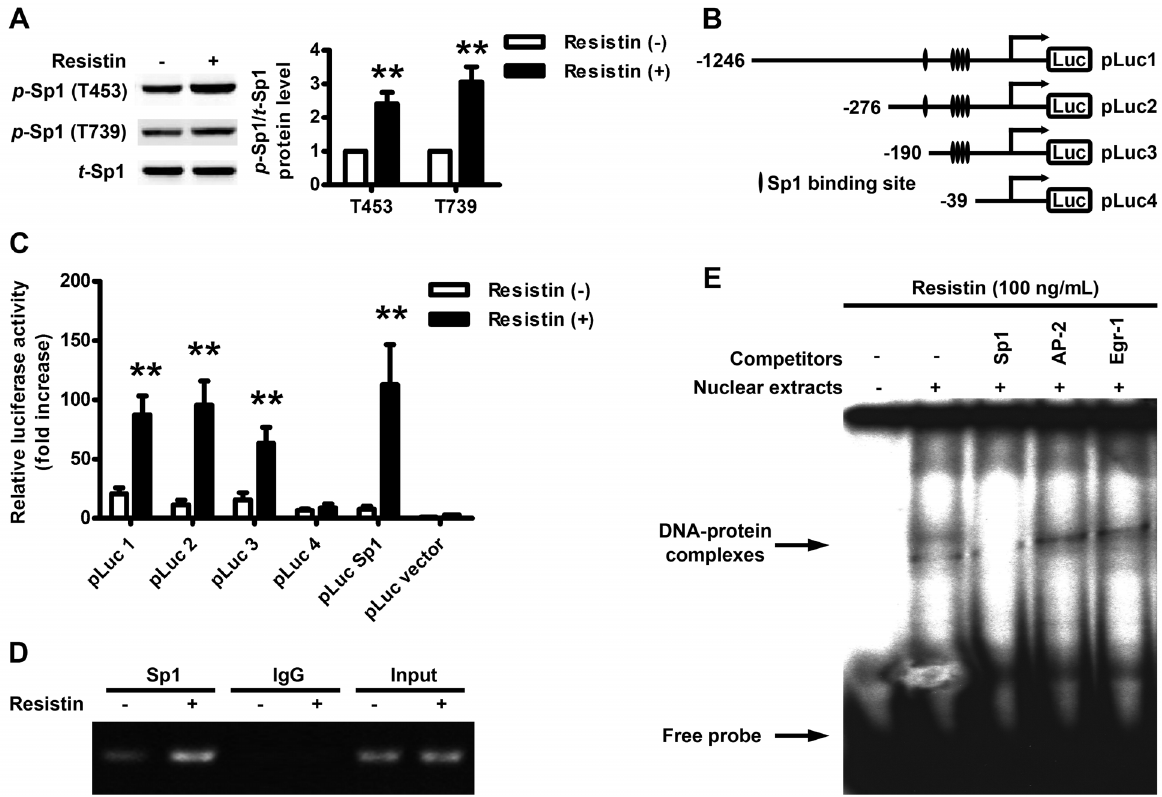
Figure 3. Sp1 acted on the motif of VEGF promoter. ( A ) Effects of resistin on Sp1 activation in HO-8910 cells. Cells were incubated with 100 ng/mL resistin for 2 h and whole-cell lysates underwent Western blotting to detect the phosphorylation of Sp1 at either Thr-453 or Thr-739; ( B ) Scheme of the series of plasmid constructs containing dissected fragments of VEGF promoter; ( C ) Relative luciferase activity in transient transfection assays using the series of plasmid constructs (schematically shown in B ) and pSp1-luciferase reporter. Relative luciferase activity was normalized with respect to the activity of PGL3-basic in untreated cells. Data are mean ± SEM from four independent triplicated experiments; ( D ) Chromatin immunoprecipitation of VEGF promoter complexes. HO-8910 cells underwent immunoprecipitation with anti-Sp1 antibody or control IgG. Immunoprecipitated chromatin fragments were amplified by PCR with specific primers targeting the predicted Sp1 binding motifs within the VEGF promoter; ( E ) Effects of various competitors in EMSA of resistin-stimulated HO-8910 cells. Competitors, including Sp1, AP-2 and Egr-1 consensus sequences, were added to the reaction mixture at a 100-fold molar excess to labeled probe, the VEGF promoter fragment containing predicted Sp1 binding motifs. Lane 2 contained no competitor. Nuclear extracts were prepared from HO-8910 cells and underwent EMSA. Cells were pre-incubated with 100 ng/mL resistin for 24